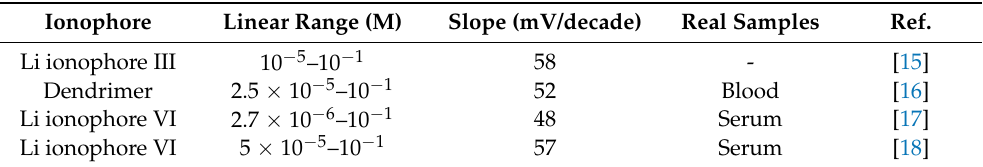
Table 1. Lithium detection by potentiometric sensors based on a polymeric ionophore-containing